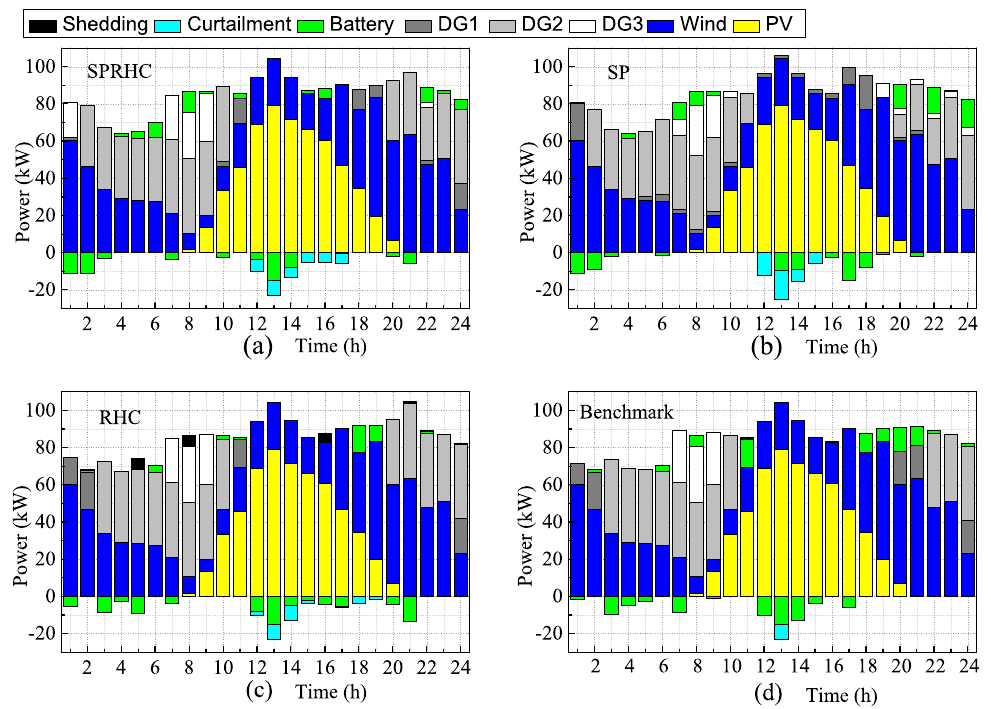
Figure 9. Power schedule in island mode ( a ) SPRHC strategy; ( b ) SP strategy; ( c ) RHC strategy; ( d ) Benchmark.